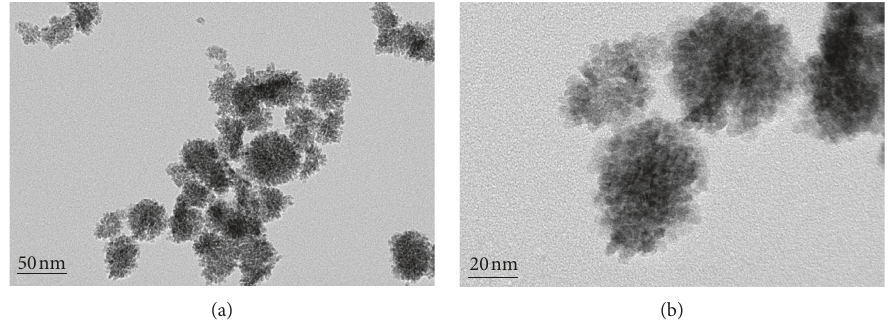
Figure 2: TEM micrographs of (a) zirconium dioxide nanoparticles and (b) close-up view of zirconium dioxide nanoparticles.